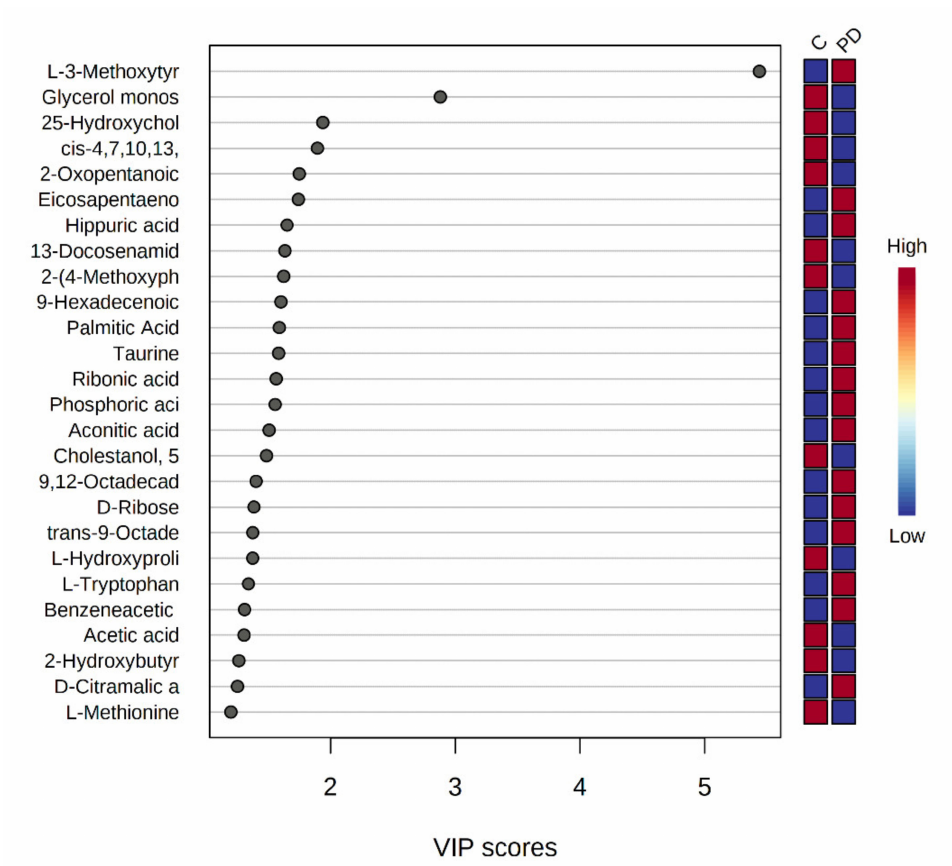
Figure 3. Variable importance in projection (VIP) of the metabolites in the PLS-DA model. The colored boxes indicate the relative peak height of the corresponding metabolite in each group under study. Metabolites with VIP value above 1.0 were visualized. The blue and red boxes on the right indicate whether the metabolite concentration is increased or decreased in the grouped into sets